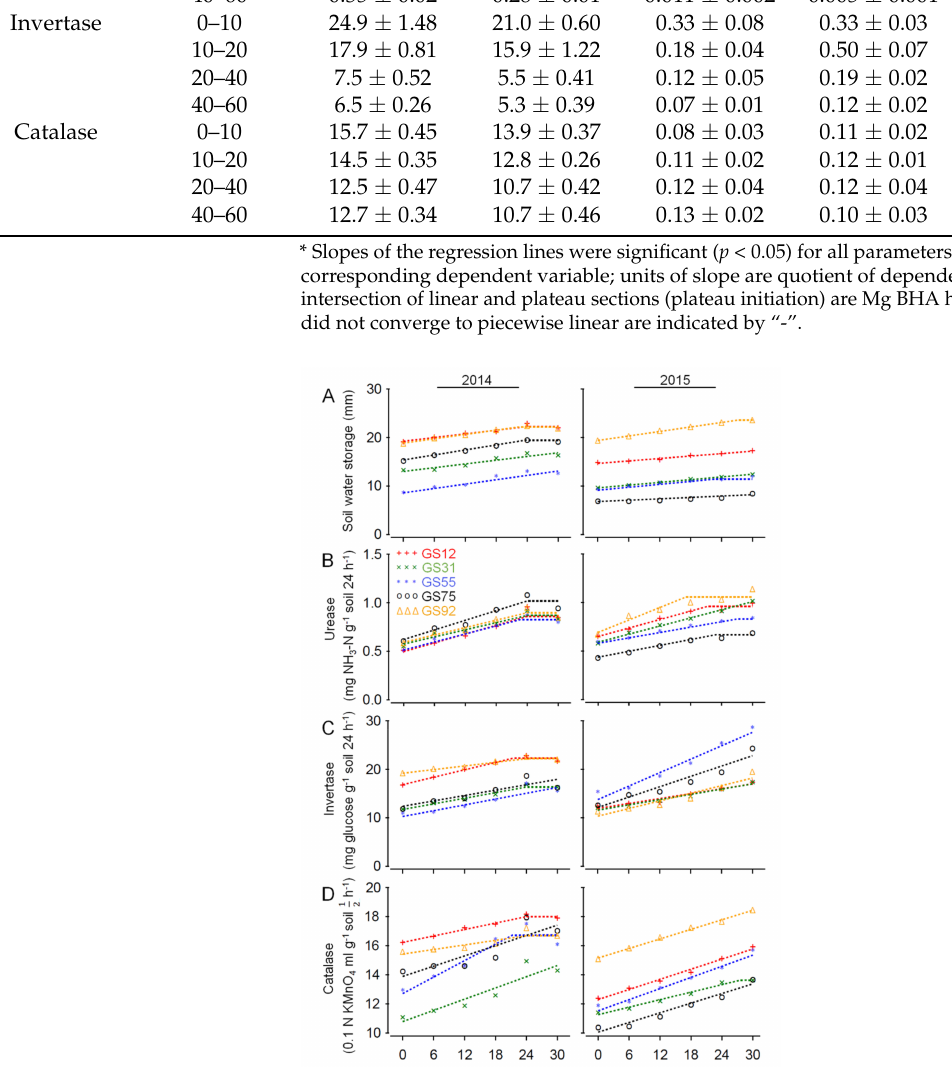
Figure 1. Means (of all growth stages) of ( A ) soil water storage and ( B ) urease, ( C ) invertase, and ( D ) catalase activity in different soil layers plotted against one-time bentonite-humic acid (BHA) applica- tion rate in 2014 and 2015. The response of dependent variable (Y) to the BHA application rate (X) was fit individually to a piecewise linear plus plateau model (dotted lines), where the slopes of the regression lines were significant ( p < 0.05) for all parameters. Colors indicate different soil depths in all panels: 0 − 10 cm (red plus), 10 − 20 cm (green × ), 20 − 40 cm (blue asterisk), and 40–60 cm (black